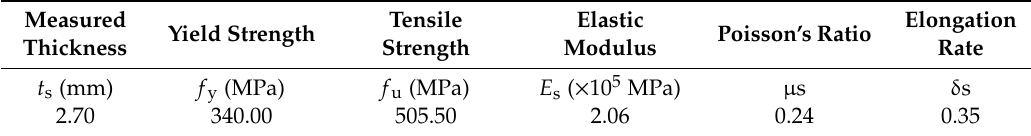
Figure 10. Drawing of Steel Material Tensile Specimen. Table 8. Mechanical Properties of Steel.